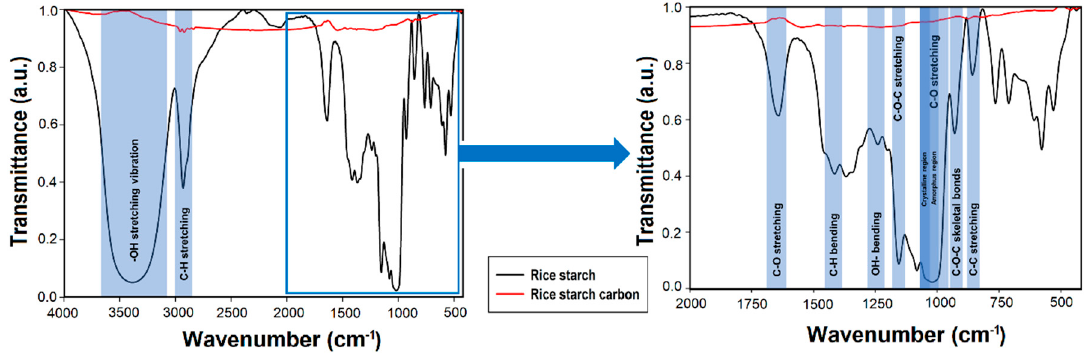
Figure 6. FTIR spectrum of the fuel before and after thermal processing.